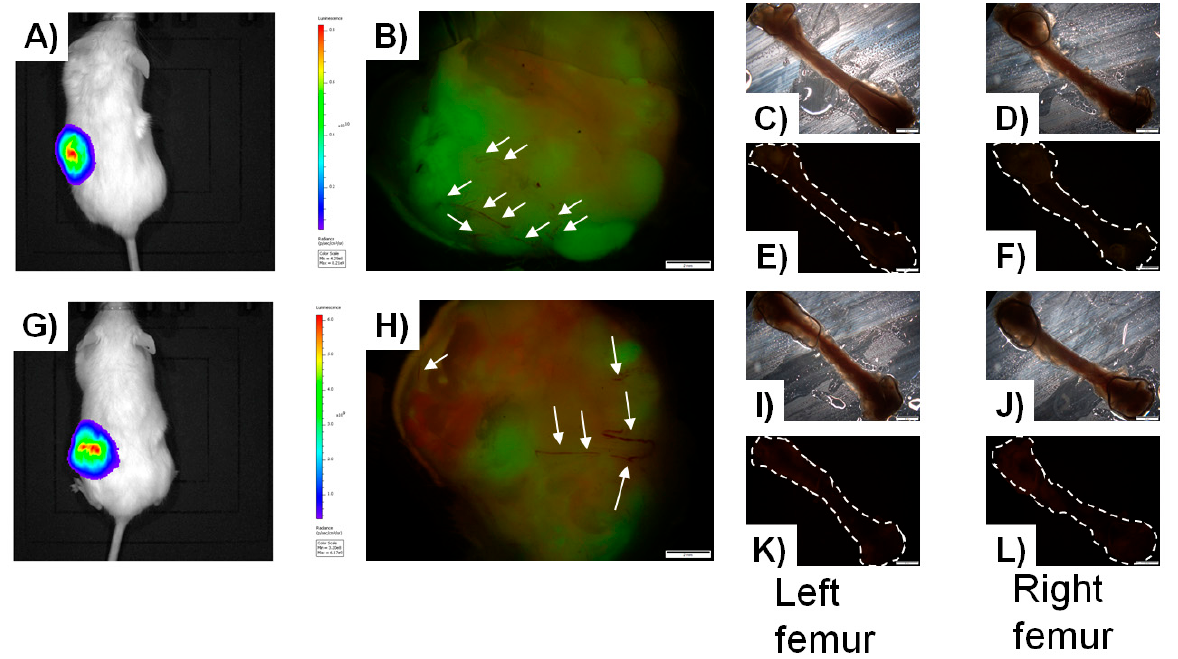
Figure 2. Printed polycaprolactone scaffolds seeded with osteoblasts plus breast cancer cells form tumors in-vivo. IVIS image of a NOD/SCID/IL-2r gamma null (NSG) mouse 2 months post-implant with a printed polycaprolactone scaffold coated with Matrigel™ then seeded with a 1:1 admix of GFP-MDA-MB-231 human breast cancer cells plus either ( A ) tdTomato MC3T3-E1 murine osteoblasts or ( G ) tdTomato murine EO cells. ( B , H ) Fluorescent microscope images of tumors from A and G ex-vivo; ( B ) 1:1 admix of GFP-MDA-MB-231 human breast cancer cells plus tdTomato MC3T3-E1 murine osteoblasts; ( H ) 1:1 admix of GFP-MDA-MB-231 human breast cancer cells plus tdTomato murine EO cells. White arrows indicate blood vessel formation in the tumors. Light microscopy images of ( C , I ) left and ( D , J ) right ex-vivo femurs of ( C , D ) NSG mouse implanted with printed polycaprolactone scaffold seeded with 1:1 admix of GFP-MDA-MB-231 human breast cancer cells plus tdTomato MC3T3-E1 murine osteoblasts, or ( I , J ) 1:1 admix of GFP-MDA-MB-231 human breast cancer cells plus tdTomato murine EO cells. Fluorescent microscopy images of ( E , K ) left and ( F , L ) right ex-vivo femurs of ( E , F ) NSG mouse implanted with printed polycaprolactone scaffold seeded with 1:1 admix of GFP-MDA-MB-231 human breast cancer cells plus tdTomato MC3T3-E1 murine osteoblasts, or ( K , L ) 1:1 admix of GFP-MDA-MB-231 human breast cancer cells plus tdTomato murine EO cells. Scale bar = 2 mm.